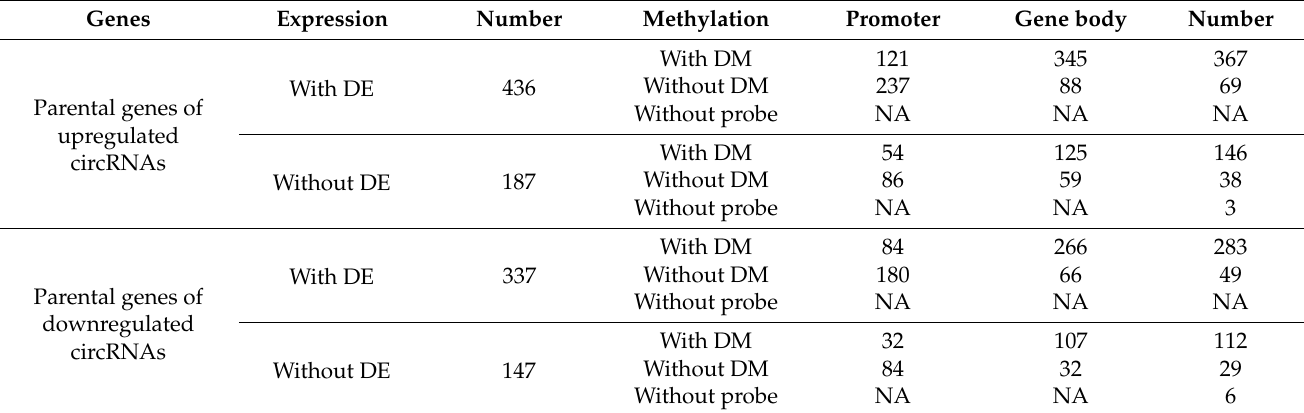
Table 4. Summary of parental genes of differentially expressed circRNAs with or without differentially methylated sites.